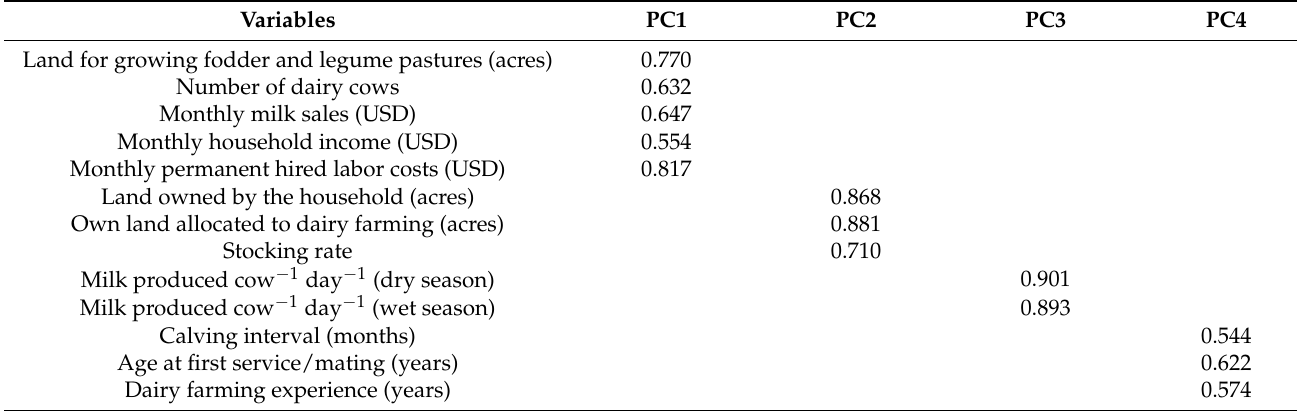
Table 4. Rotated component matrix for variables that define the extracted PCs considered for